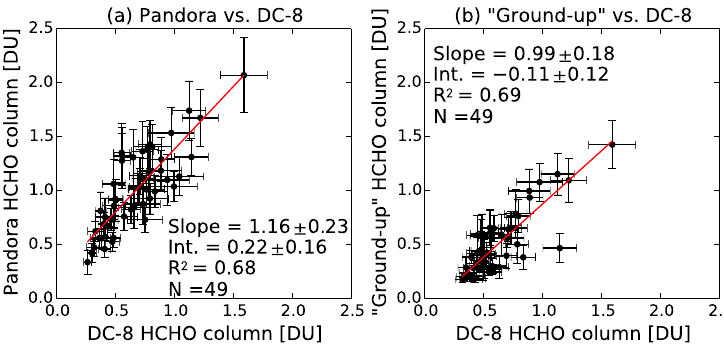
Figure 10. Correlation between HCHO columns for (a) Pandora and DC-8-integrated vertical columns and (b) “ground-up” (surface vmr within measured MLH, box profile shape) and DC-8-integrated columns at Olympic Park and Mt. Taehwa during